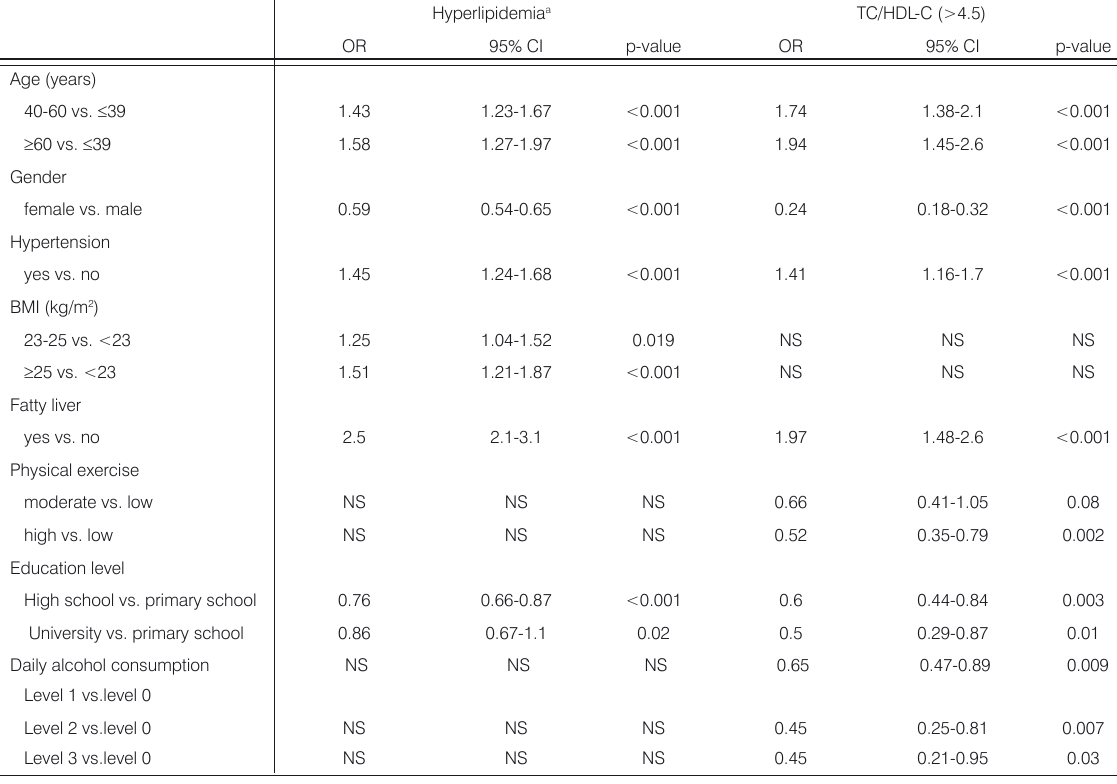
Table 3. OR for dyslipidemia for various risk